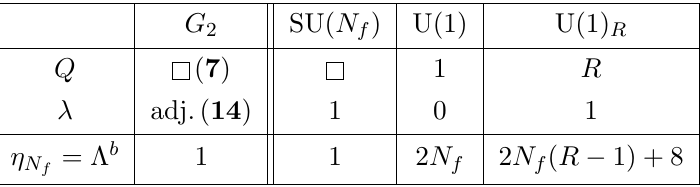
Table 1 . Quantum numbers of the 4d N = 1 G 2 gauge